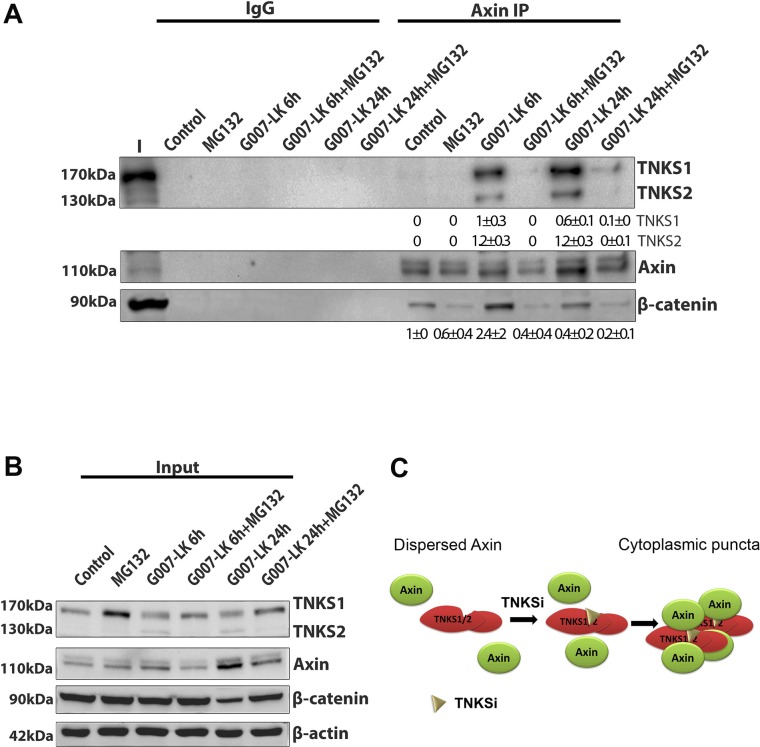
TNKSi induces the binding of TNKSs to axin.A. SW480 cells were untreated or treated for 6 h or 24 h with 5 μM G007-LK (+/- 6 h with 20 μM MG132), then cell extracts were harvested and subjected to immunoprecipitation (IP) analysis with an axin antibody to detect axin-protein complexes. The immunoprecipitates were separated by SDS-PAGE and analysed by western blot. As shown, an increase in binding of both TNKS-1 and -2 to axin was observed after TNKSi treatments. In addition, an increase in β-catenin binding to axin was seen after 6 h treatment. In the presence of MG132, the induction of TNKS-axin complexes by G007-LK was blocked as shown. Quantification of axin-bound TNKS-1, TNKS-2 and β-catenin band intensities from two separate experiments are shown (mean ± SD). Values are corrected towards the total axin pulled down per sample. B. Western blot of total protein extract demonstrates that total levels of TNKSs were not modified by TNKSi treatment, but displayed a modest increase after 6 h MG132. The G007-LK treatment did modestly increase axin levels (and decrease β-catenin levels after 24 h treatment) as expected. This control blot indicates that the strong induction of TNKS-axin complexes above is not due to changes in protein expression. C. A diagram outlining how these novel effects of TNKSi on axin-TNKS complexes may contribute to axin/TNKS positive puncta formation in the cell.